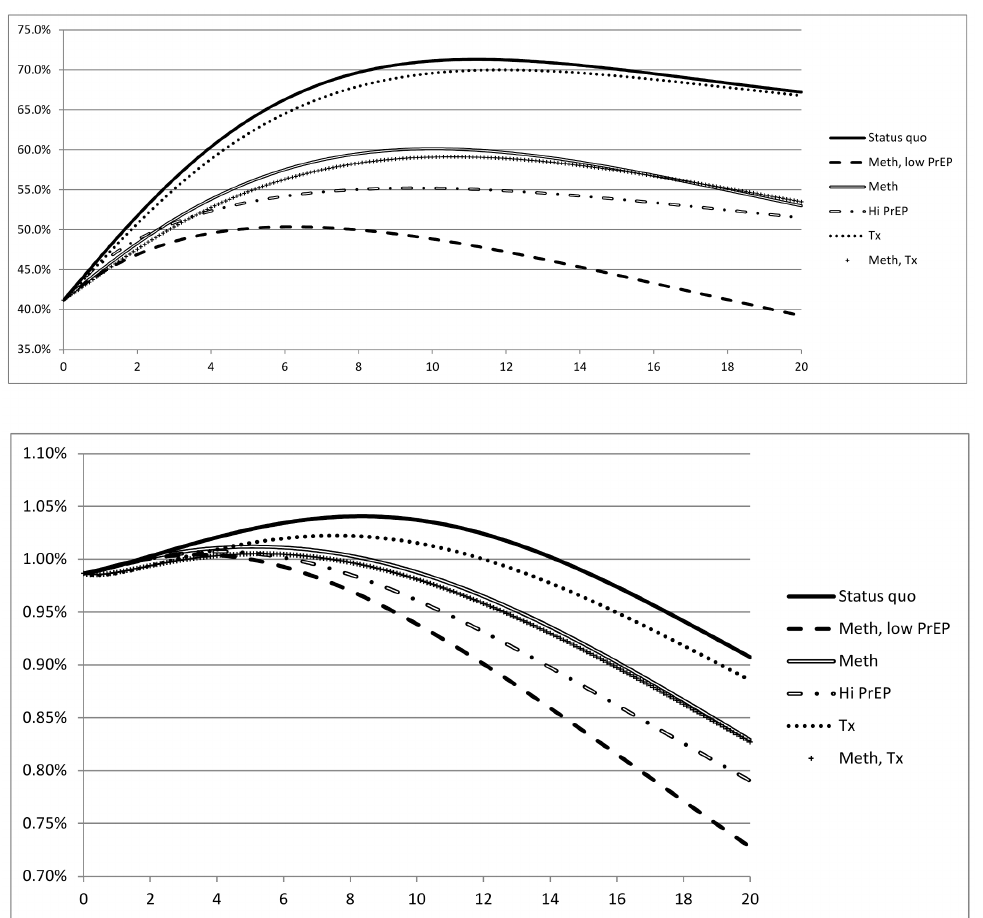
Figure 1. HIV prevalence over 20 years for alternative strategies. Prevalence is shown for the status quo and alternative strategies of scaling up antiretroviral therapy (ART) to 80% of all eligible individuals, methadone maintenance treatment (MMT) for 25% of injection drug users (IDUs), and introducing oral pre-exposure prophylaxis (PrEP) for 25% or 50% of uninfected IDUs.